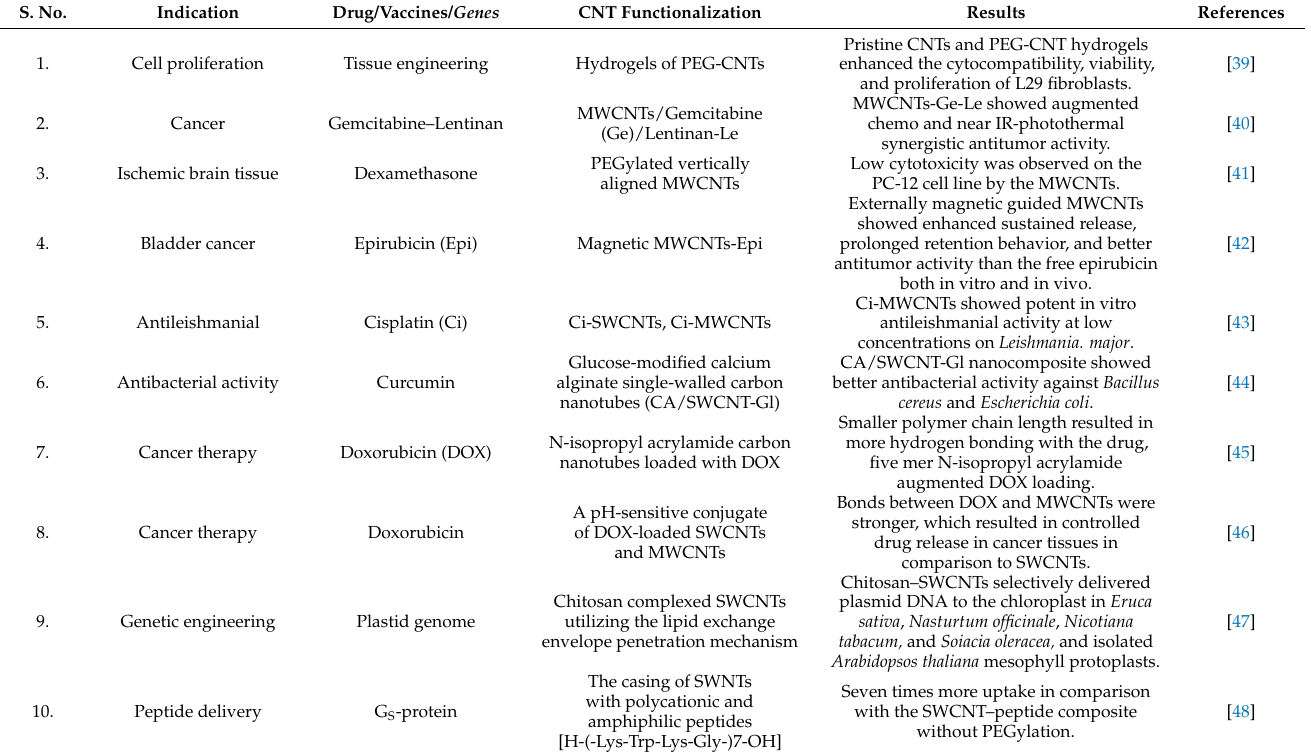
Table 2. Recent advancement in carbon nanotube-based